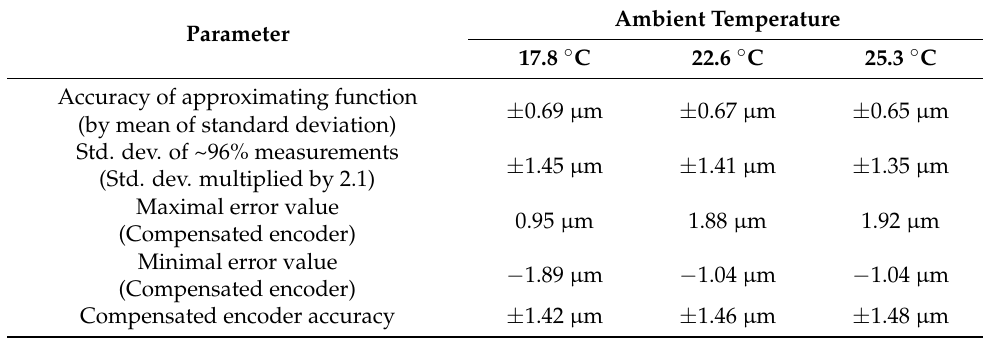
(including experimentally estimated real thermal